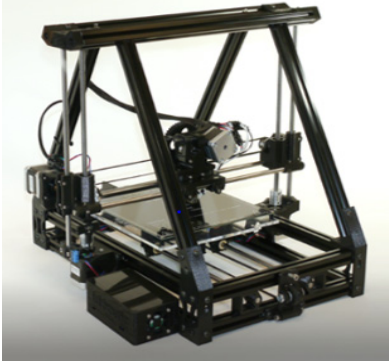
Figure 2. Fabbmatic Mendelmax 1.5 FM Pro Desktop 3D Printer [11].